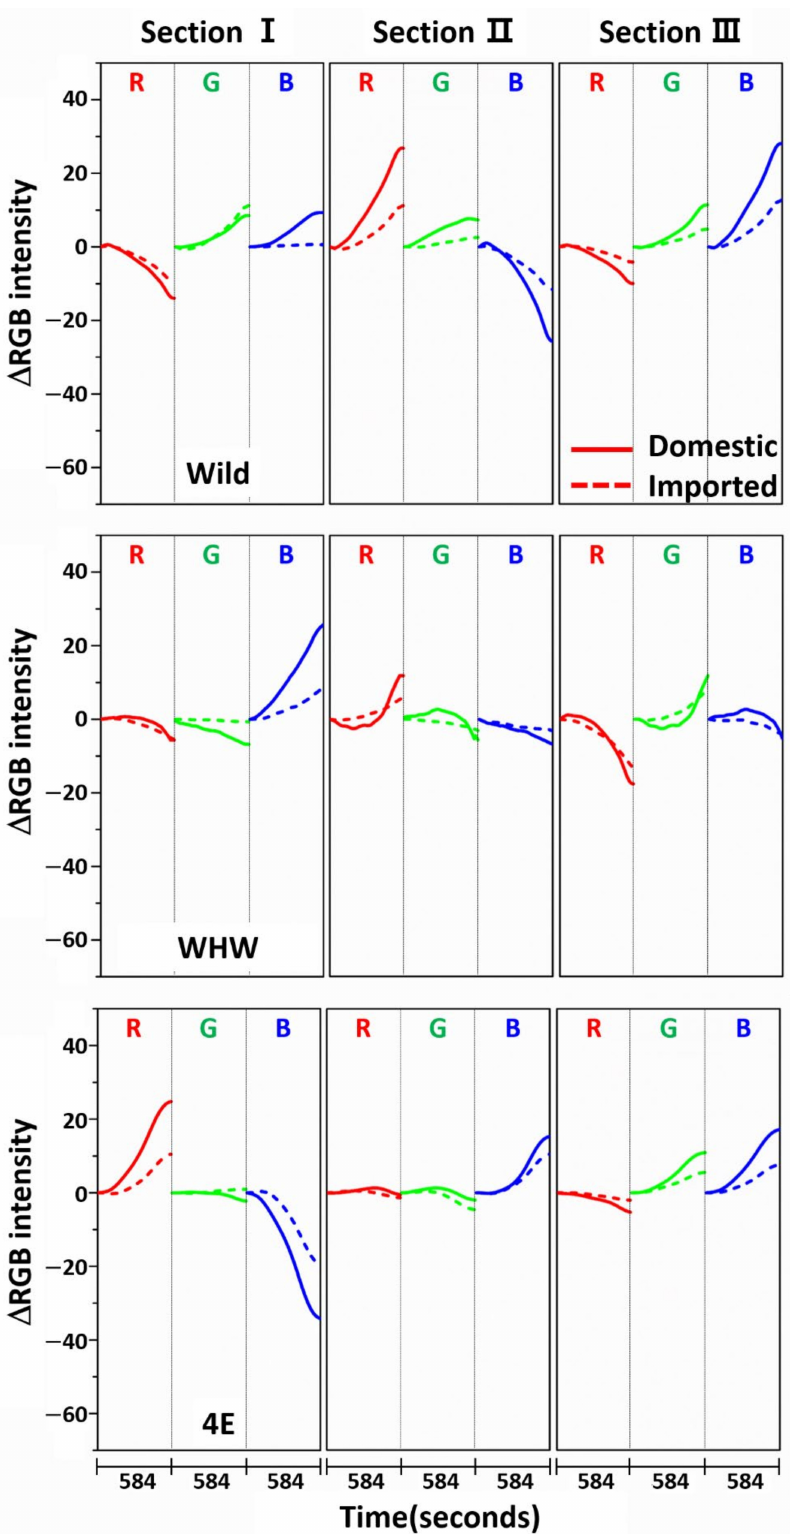
Figure 3. Average ∆ RGB intensity of garlic samples measured in the three sections of Wild, WHW, and 4E sensors. The solid and dotted lines indicate the domestic and imported samples,